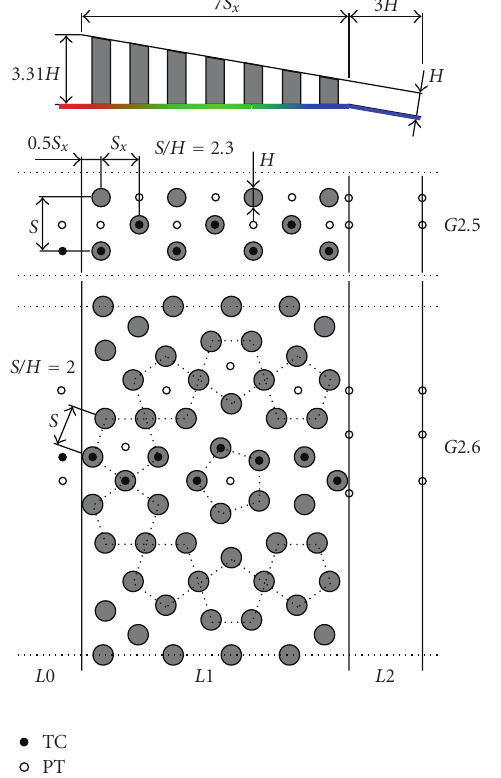
Figure 3: Circular pin fin geometries with staggered ( G 2.5) and pentagonal arrangement ( G